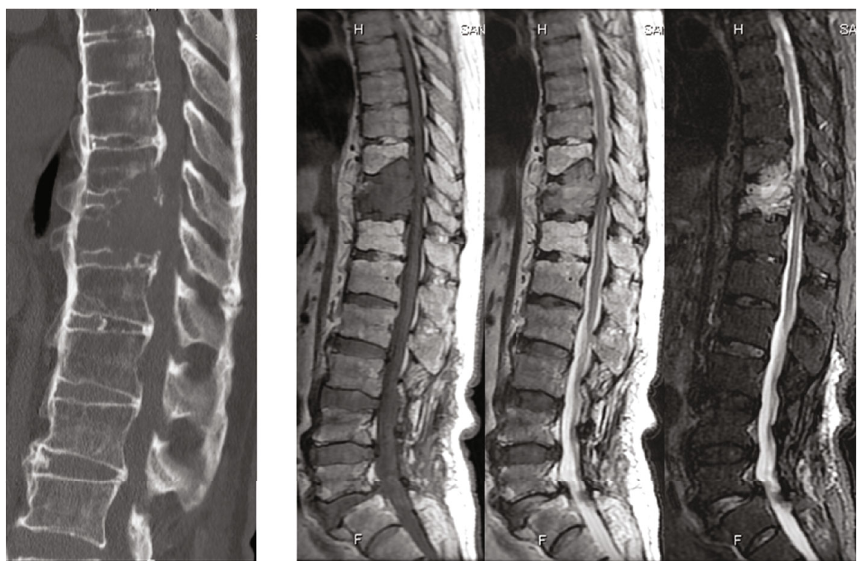
Figure 1: An 80-year-old man with renal cell carcinoma (RCC) and metastasis to the thoracic spine, lungs, and lymph nodes was paralyzed in both lower limbs 5 years earlier.